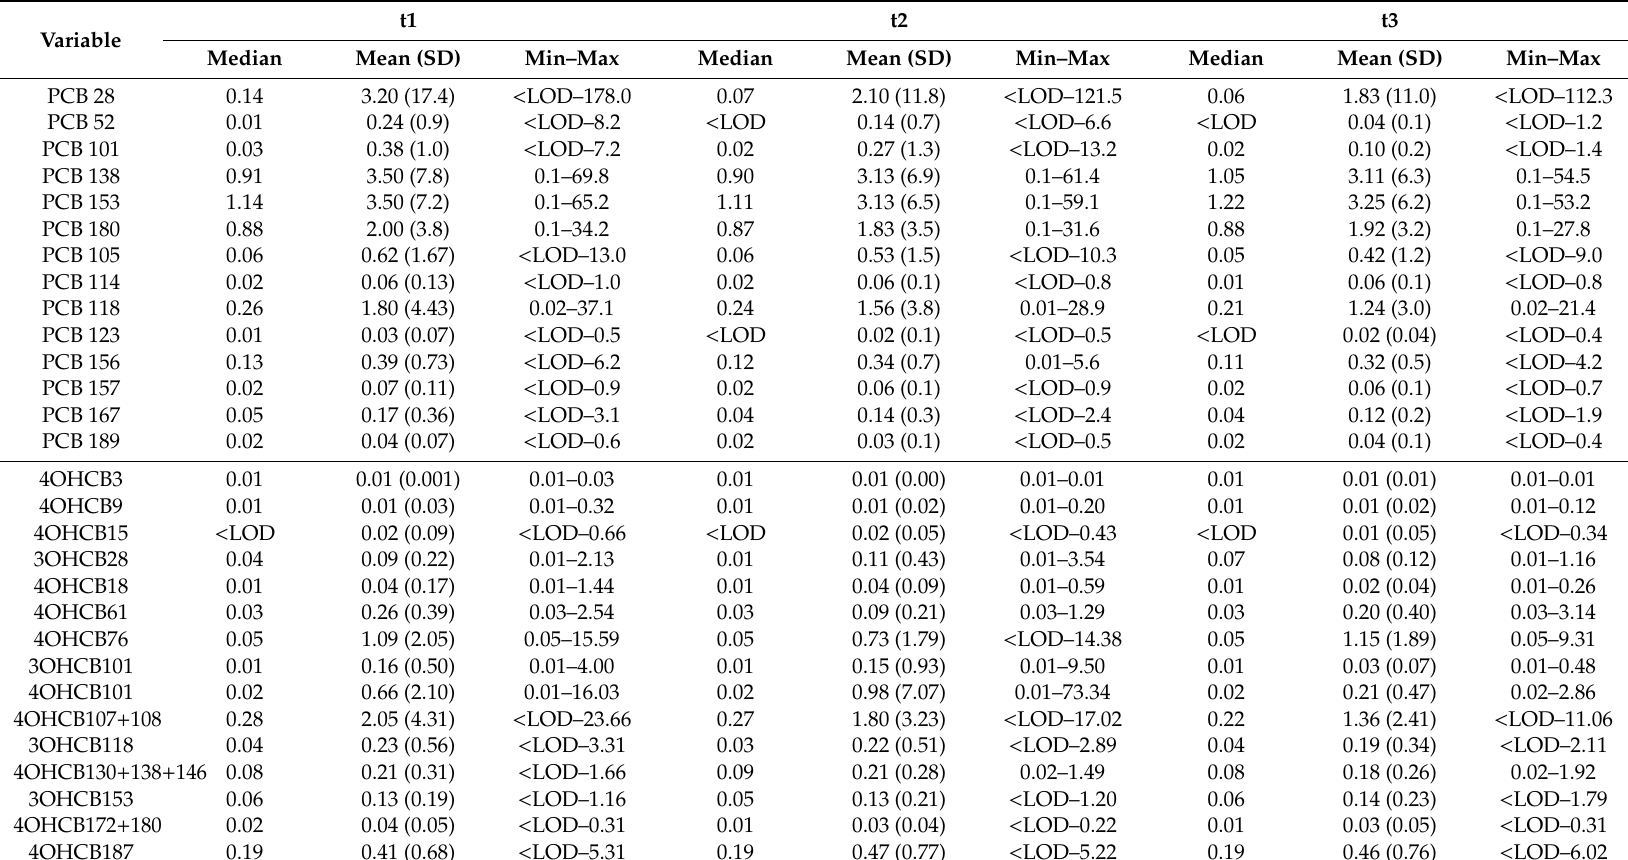
Table A1. PCB-body burden of the included